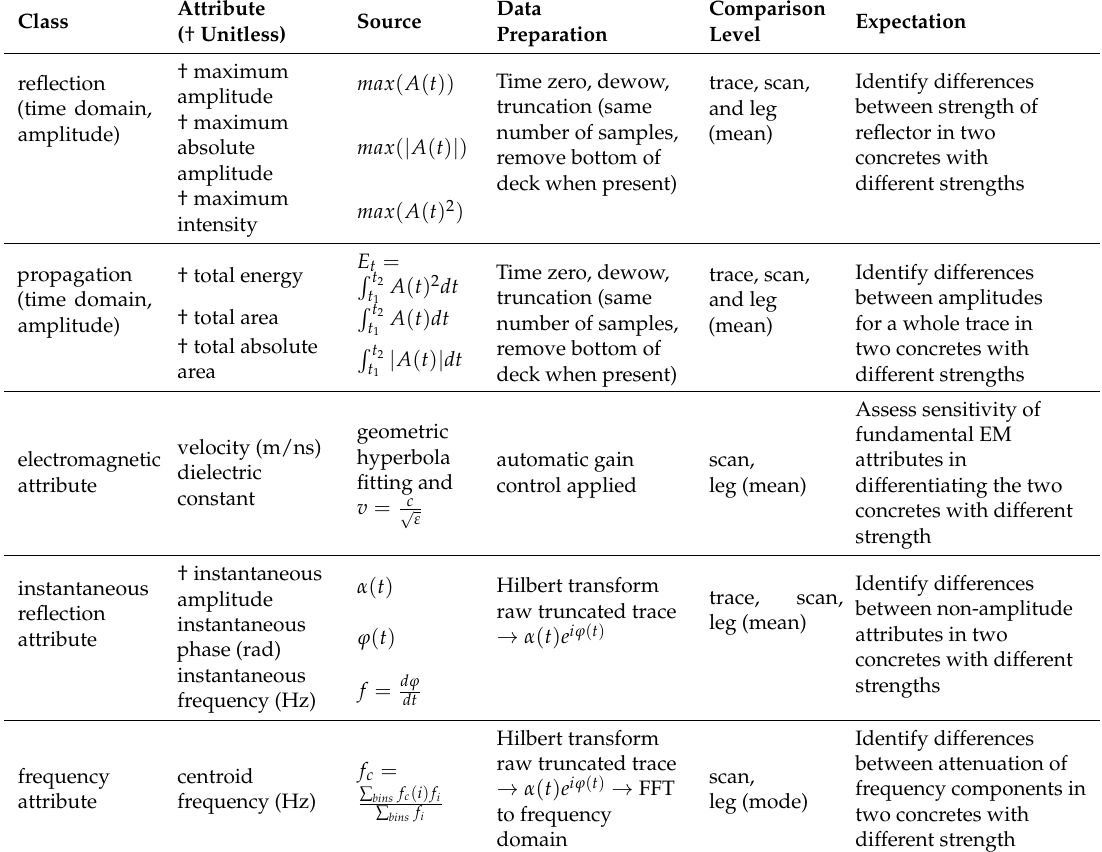
Table 1. Summary of studied